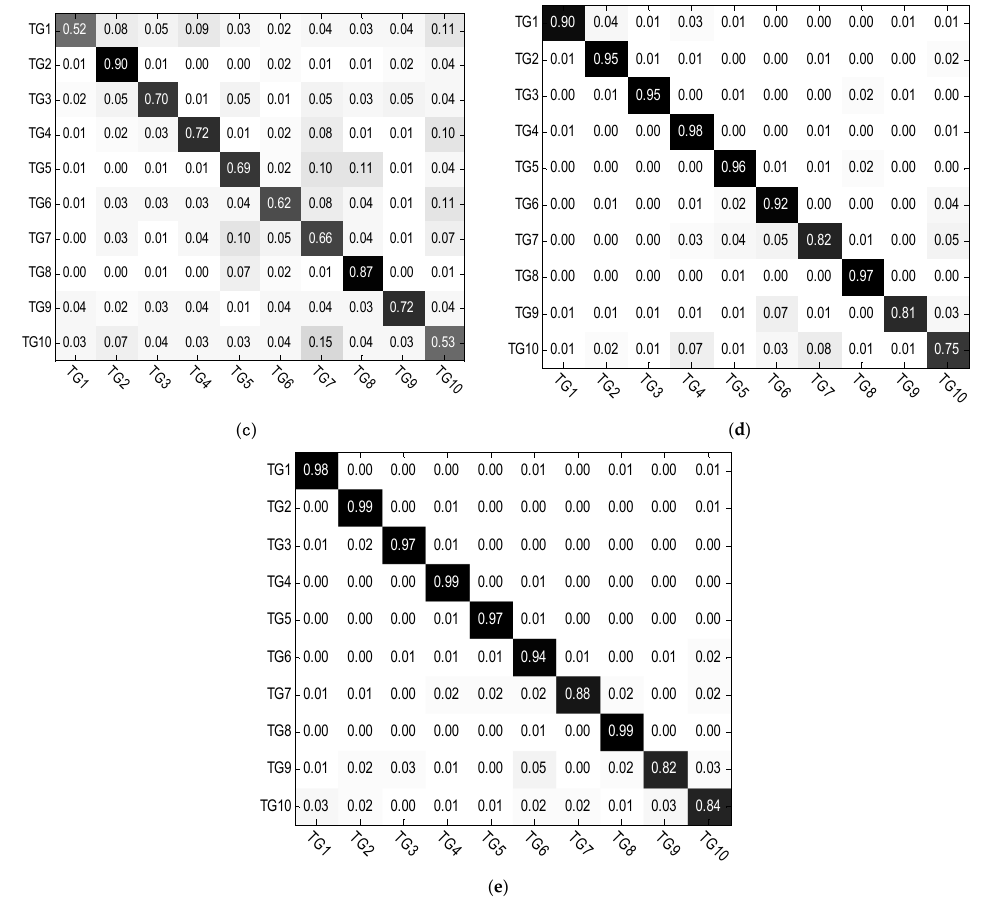
Figure 15. Confusion matrix of different methods. ( a ) SRC; ( b ) CRC; ( c ) LC-KSVD; ( d ) GADPL; ( e ) ALADPL.